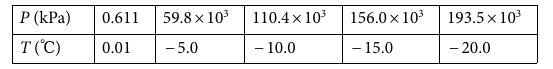
Table 2. Solid–liquid phase transition point of water.